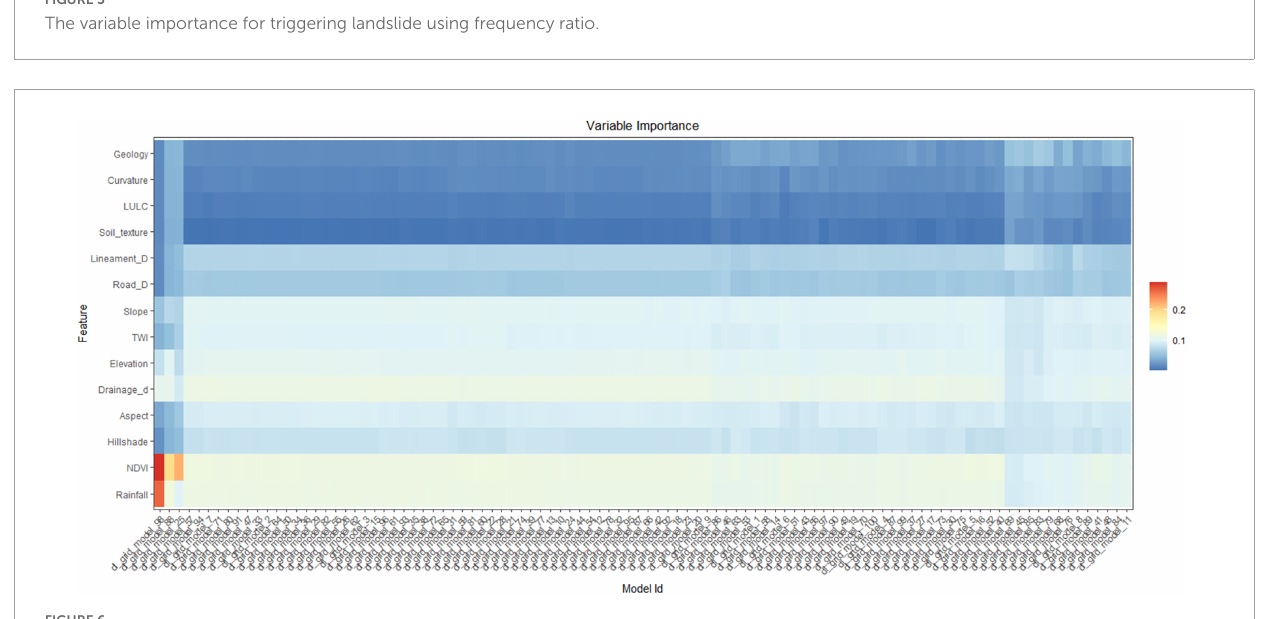
FIGURE6 Computation of important variables for predicting LSM as per the top 100 DNN